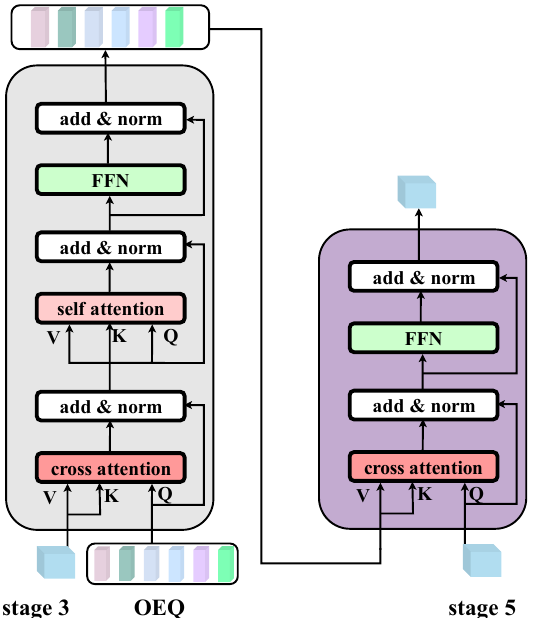
Figure 4. Illustration of the transformer decoder ( left ) and the transformer encoder ( right ) after SFP stage 3.